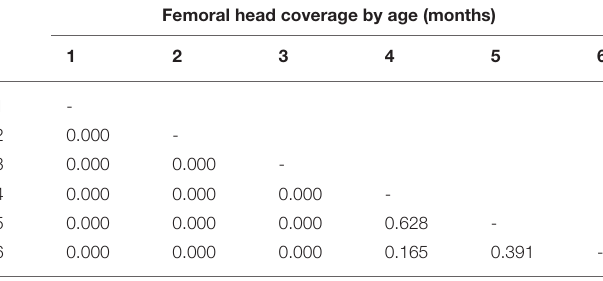
The data in the table represent the P-values calculated by analysis of variance test.